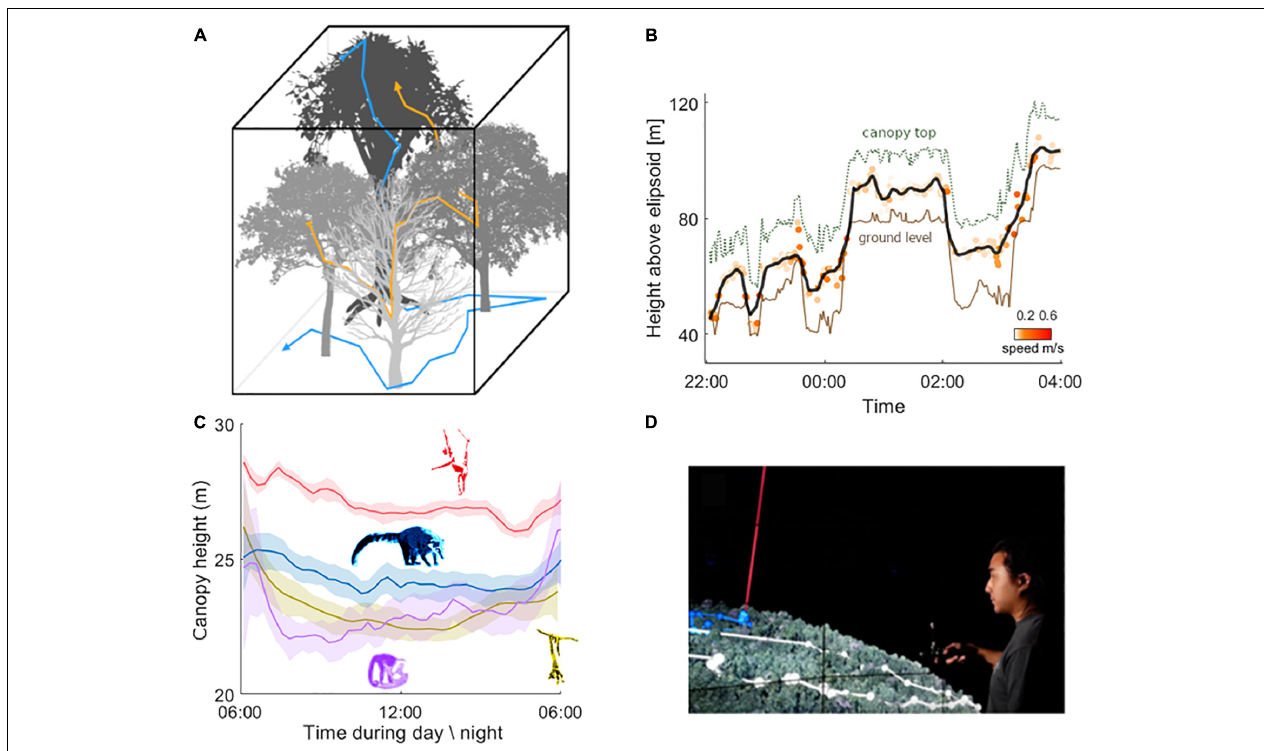
FIGURE 1 | A virtual window into a 2.5D world. (A) Integrating three-dimensional animal movement tracks with the mapping of these complex three-dimensional habitats, will enable us to study how animals navigate the branching structures of their arboreal environments. (B) Vertical movement track over time of an arboreal kinkajou ( Potos flavus ) in reference to ground (brown solid line) tracked on Barro Colorado Island, Panama, and canopy height (green dashed line). GPS data were sampled at 1 Hz and dots represent 1-min median values. The solid black line represents a running median of the height measurements over a 15-min interval. (C) Based on the animal’s horizontal movements we can extract where in the canopy animals move over the course of the day. Spider monkeys ( Ateles geoffroyi , red) tend to stay in higher canopy areas, while coatis ( Nasua narica , blue), capuchins ( Cebus capucinus , purple), and kinkajous (yellow) move through areas with lower canopy heights. The averages (and 95% CI shading) over the active period for four arboreal mammals species: coati (blue, N = 17 individuals), kinkajou (purple, N = 13 individuals), capuchin (yellow, N = 8 individuals), and spider monkey (red, N = 8 individuals) are presented. Each line represents the cumulative average values smoothed over 15-min of the individuals of a single species during the activity time of the individuals. Sources of DEM (digital elevation model) and canopy height data (Havmøller et al., 2021). Coatis sleep high in trees and descend to the ground in the mornings, forage on the ground during the day to return up into the trees at night (Kaufmann, 1962). Kinkajous and capuchins stay within the canopy and are known to only rarely come to the ground. Spider monkeys spend the majority of their day high in the canopy and have the least overall variation in vertical positioning. (D) Sensei-Panama visualization in CAVE2, visualizes animal movement trajectories within a virtual tropical environment, reconstructed from sensor and image data. Animal movements are shown with points connected by